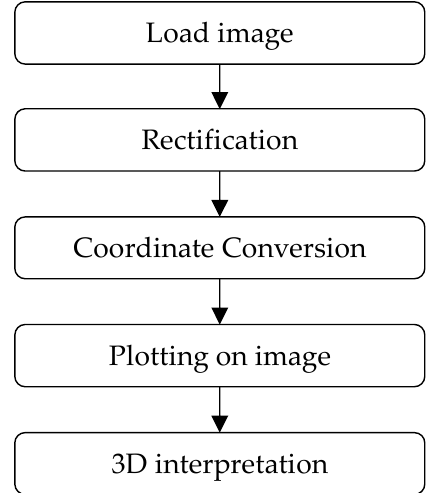
Figure 10. Process of image interpretation.